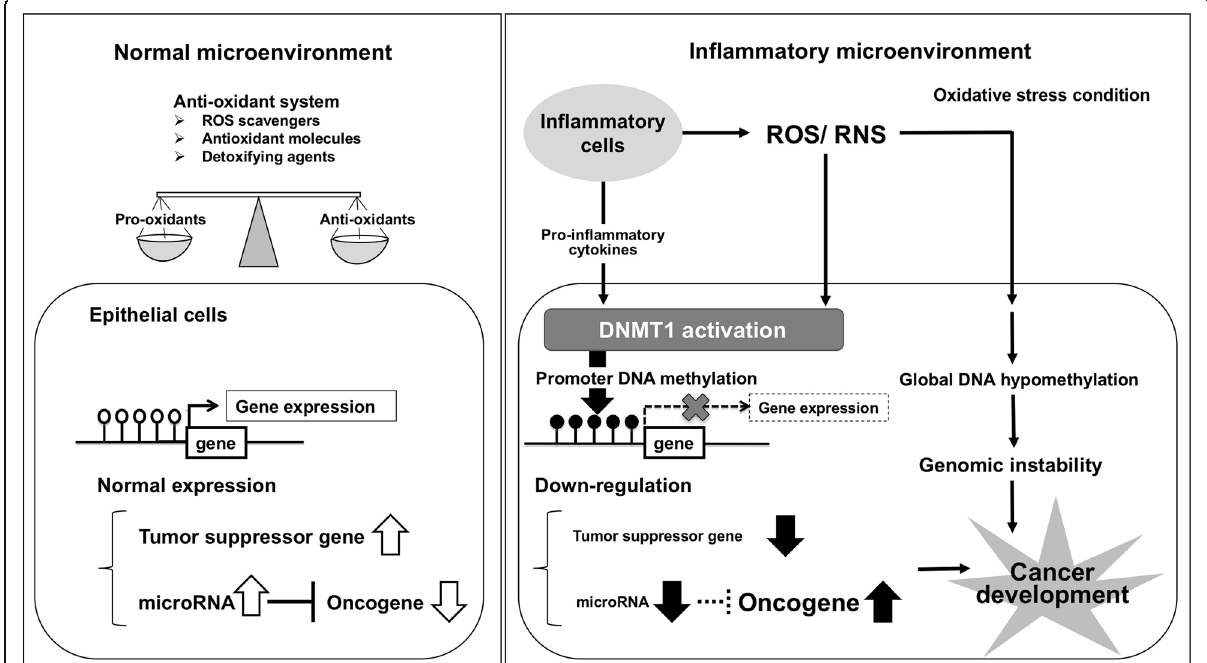
Fig. 2 Epigenetic alterations under an inflammatory microenvironment. White circles indicate unmethylated CpG sites, and black circles show methylated CpG sites in the promoter